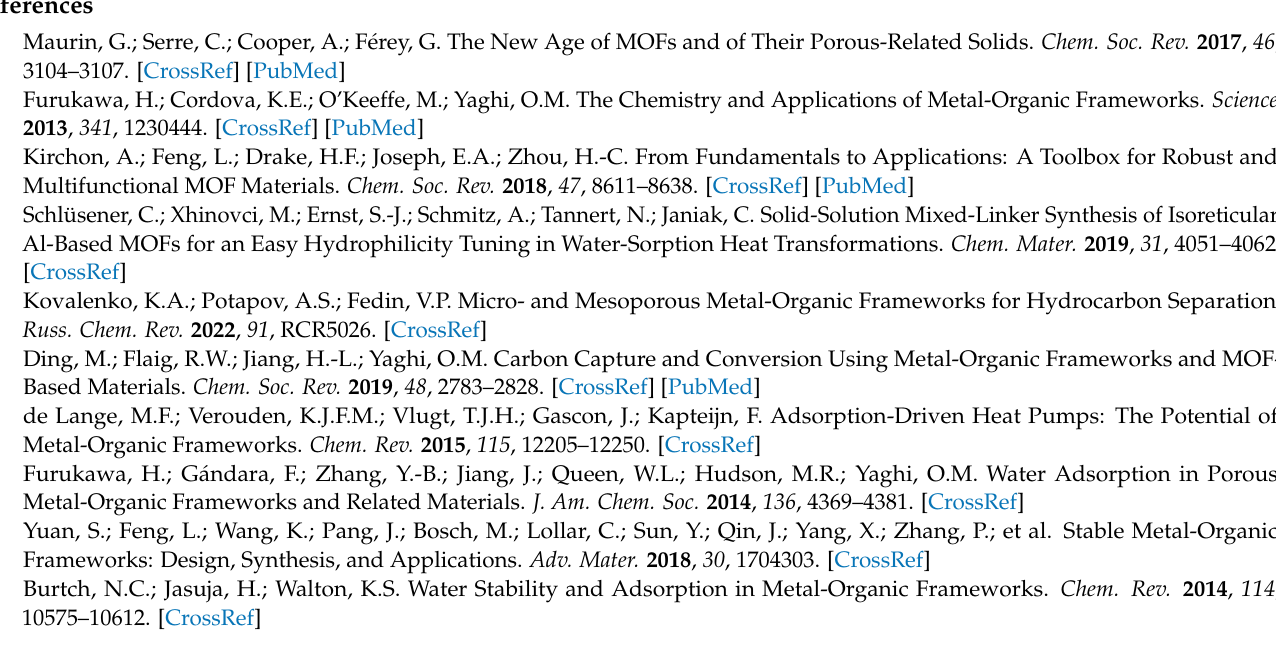
materials; Figure S2: (a) Calculated powder XRD pattern of MIL-100(Al) without adsorbed water, (b) calculated powder XRD pattern of MIL-100(Al) with adsorbed water and (c) measured XRD pattern after hydrothermal experiment; Figure S3: SEM images of MIL-96(Al), MIL-100(Al) and MIL-110(Al) adsorbents before and after 40-cycles hydrothermal treatment; Figure S4: N 2 adsorption isotherms of MIL-96(Al), MIL-100(Al) and MIL-110(Al) materials before 40-cycles hydrothermal treatment; Figure S5: N 2 adsorption isotherms of MIL-96(Al), MIL-100(Al) and MIL-110(Al) materials in the relative pressure range below p/p 0 < 0.2 before and after 40-cycles hydrothermal treatment; Figure S6: DRIFT spectra in the 5500–4500 cm − 1 region of MIL-96(Al) heated at 200 ◦ C (red) and cooled at 50 ◦ C (blue) in a stream of humid air; Table S1: Isosteric heats of adsorption of MIL-96(Al), MIL-100(Al) and